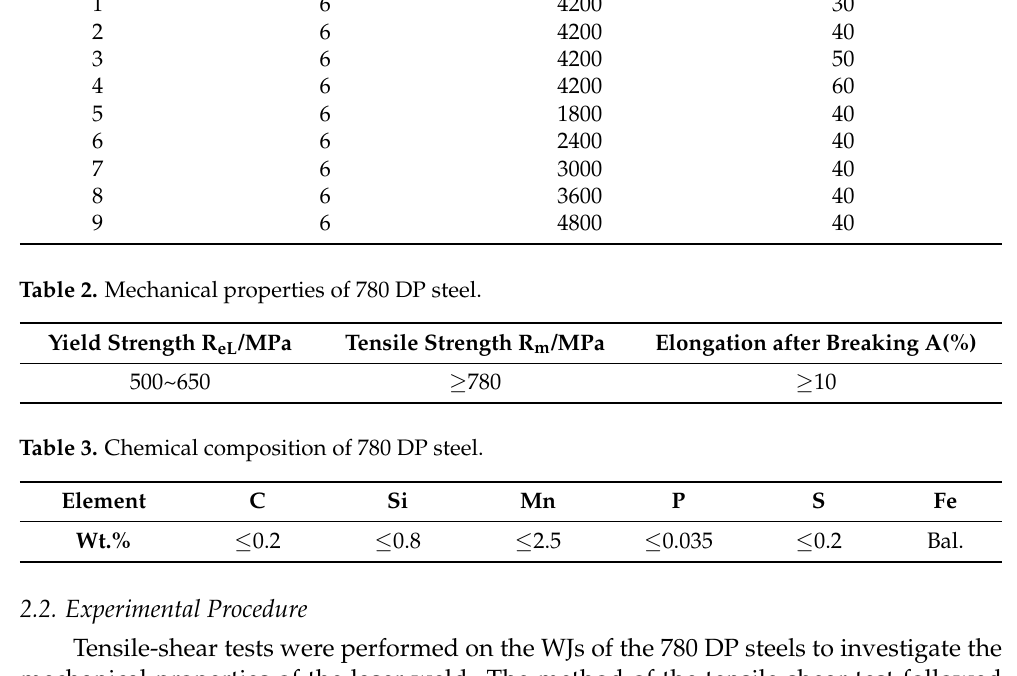
Table 3. Chemical composition of 780 DP steel.